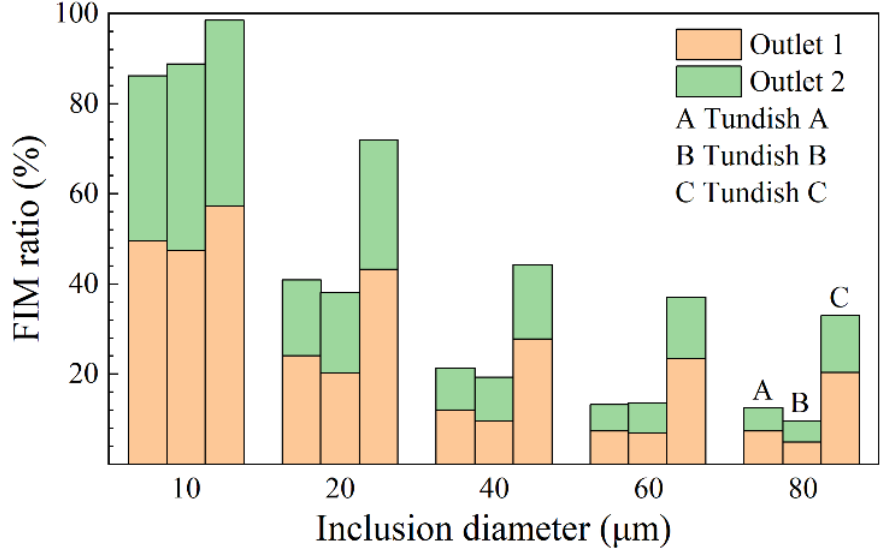
Figure 21. Ratio of inclusions flowing into the mold (FIM ratio).